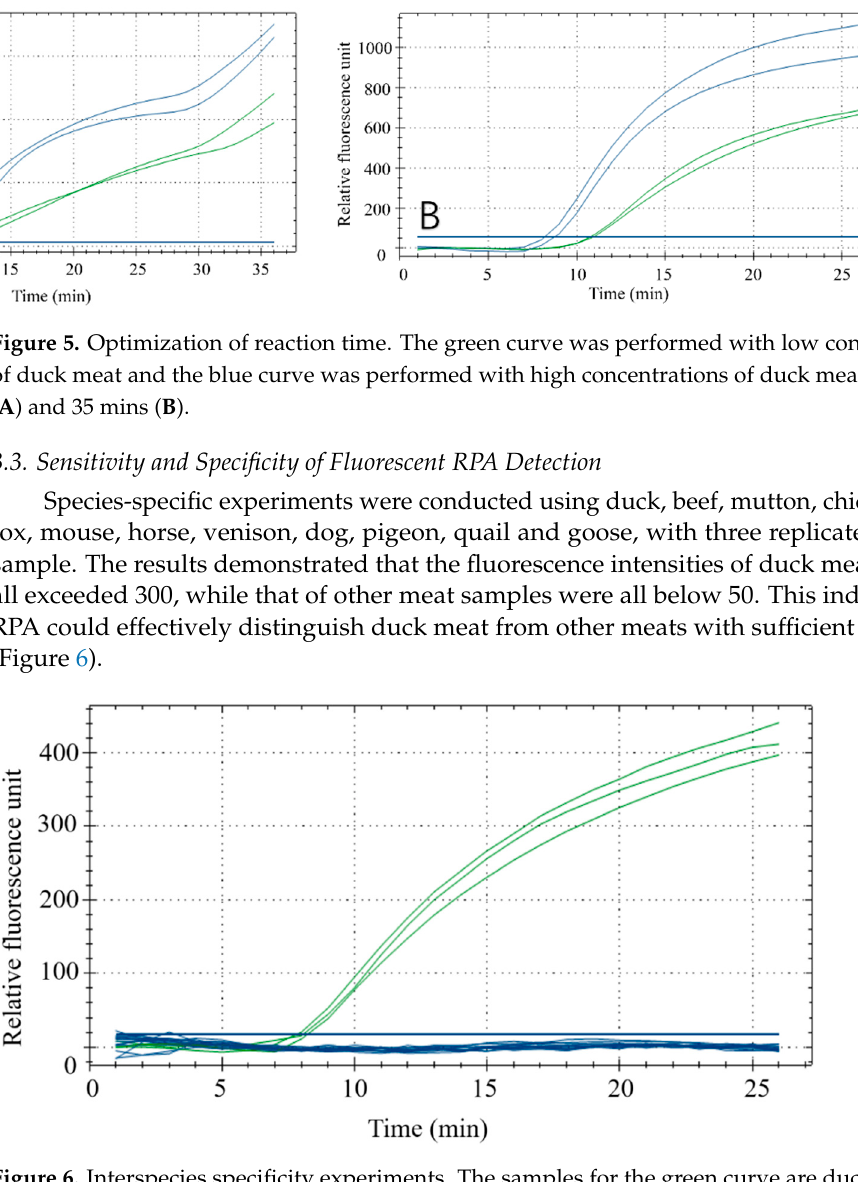
Figure 4. Screening of the optimal temperature for the RPA reaction.